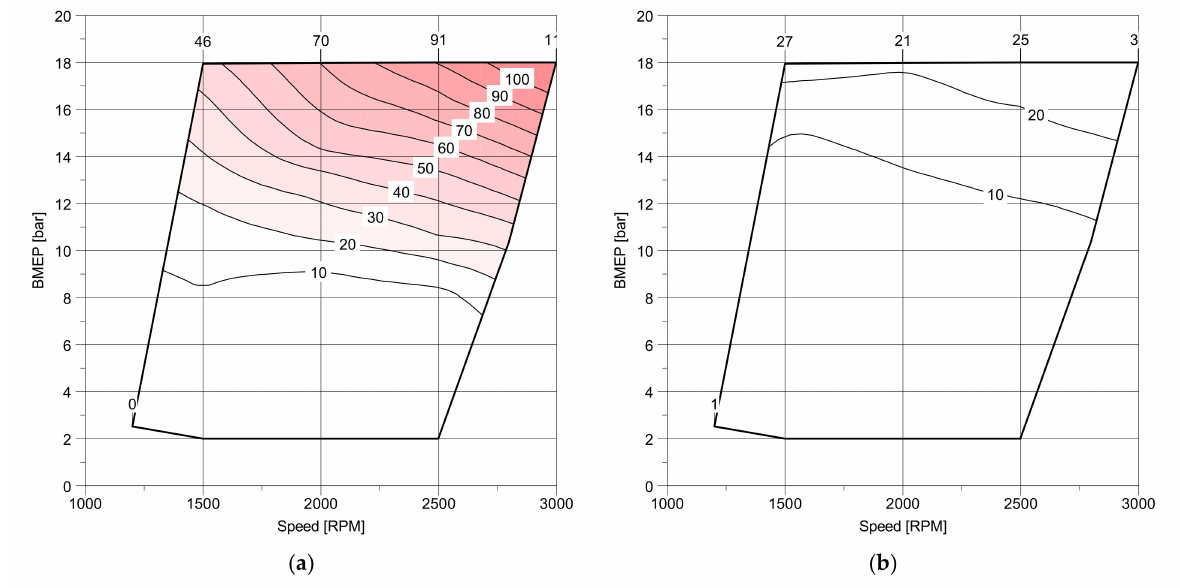
Figure 15. ( a ) Blow-down port pressures map; ( b ) scavenging port pressures map.